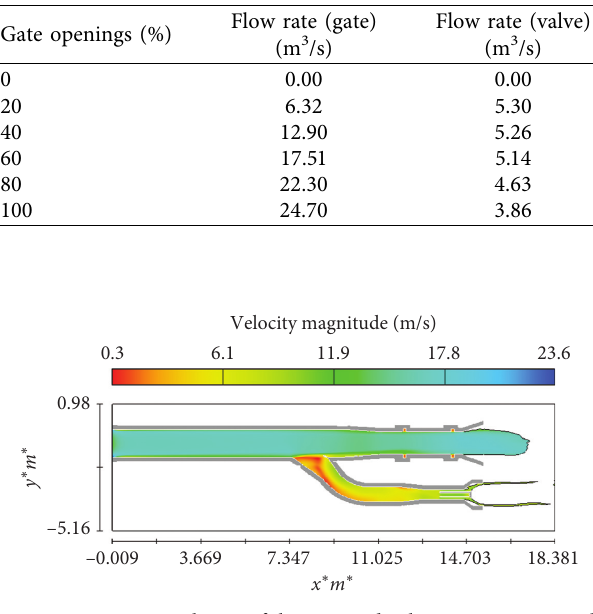
Figure 11: Output velocity of the gate and valve in 100% gate and valve opening.